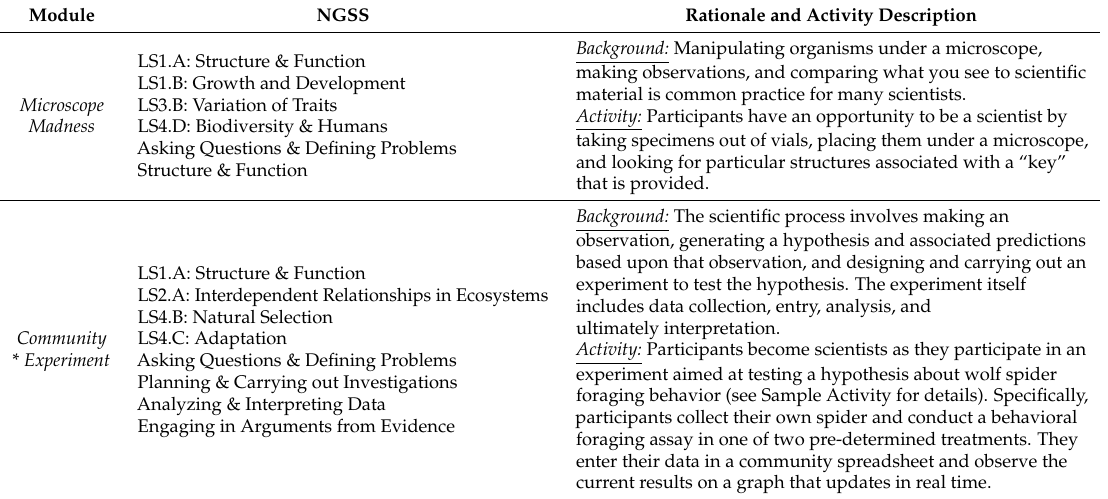
Table 5. Hands-on Science Activities’ alignment with NGSS (Disciplinary Core Ideas, Science & Engineering Practices, Cross-Cutting Concepts), and brief descriptions.